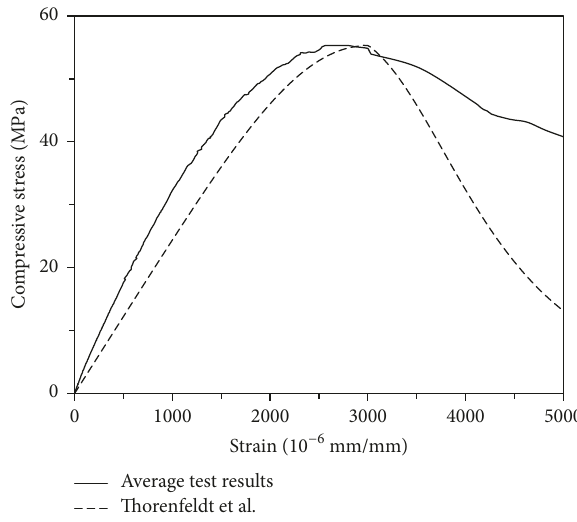
Figure 1: Stress-strain relationship of considered AAS concrete in